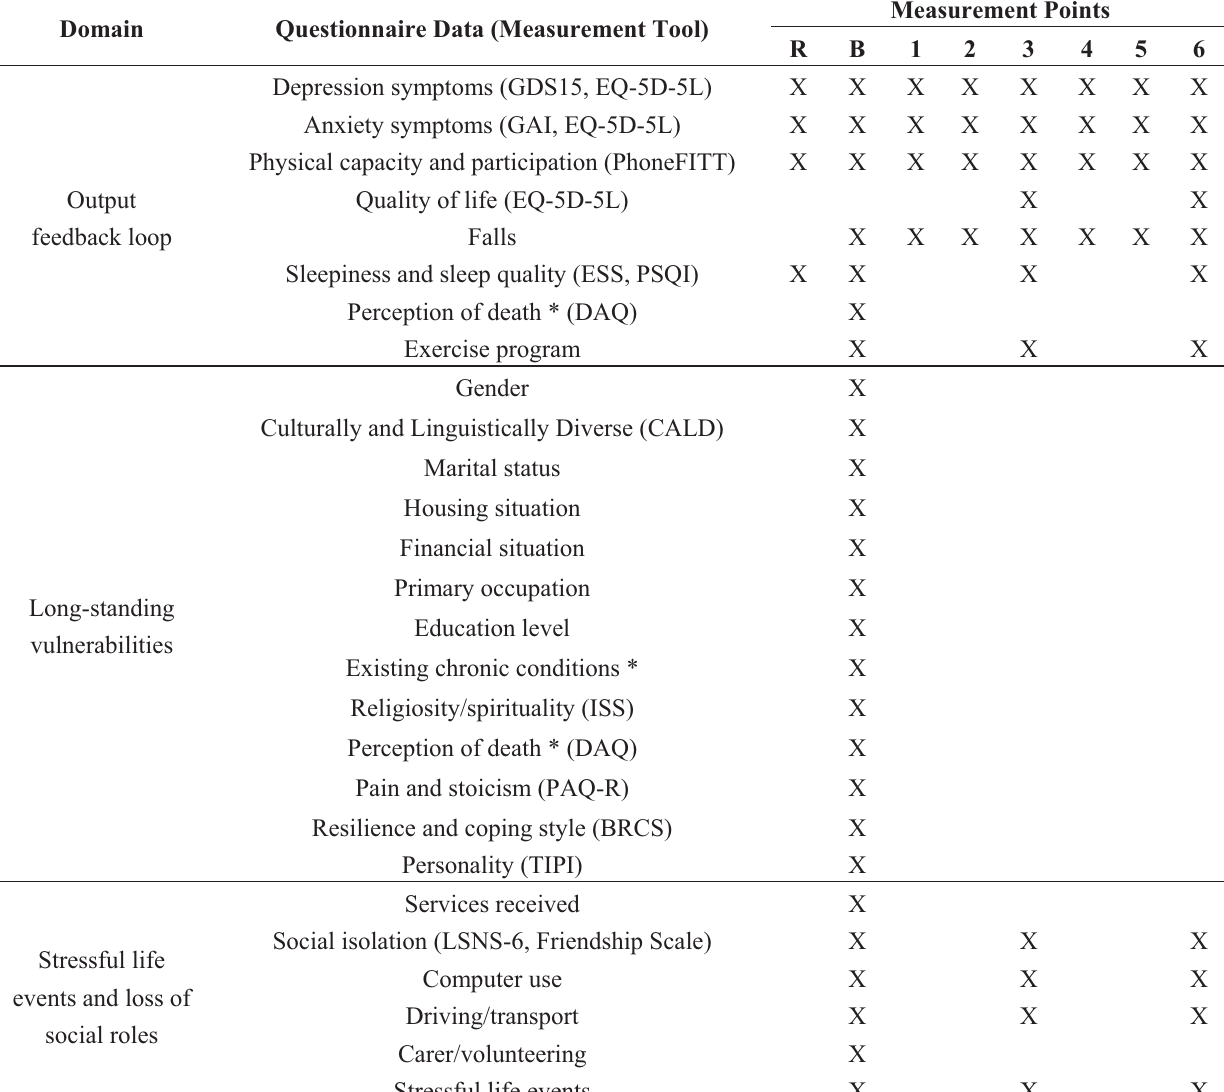
Table 1. Summary of the key domains assessed via questionnaire in the study of older